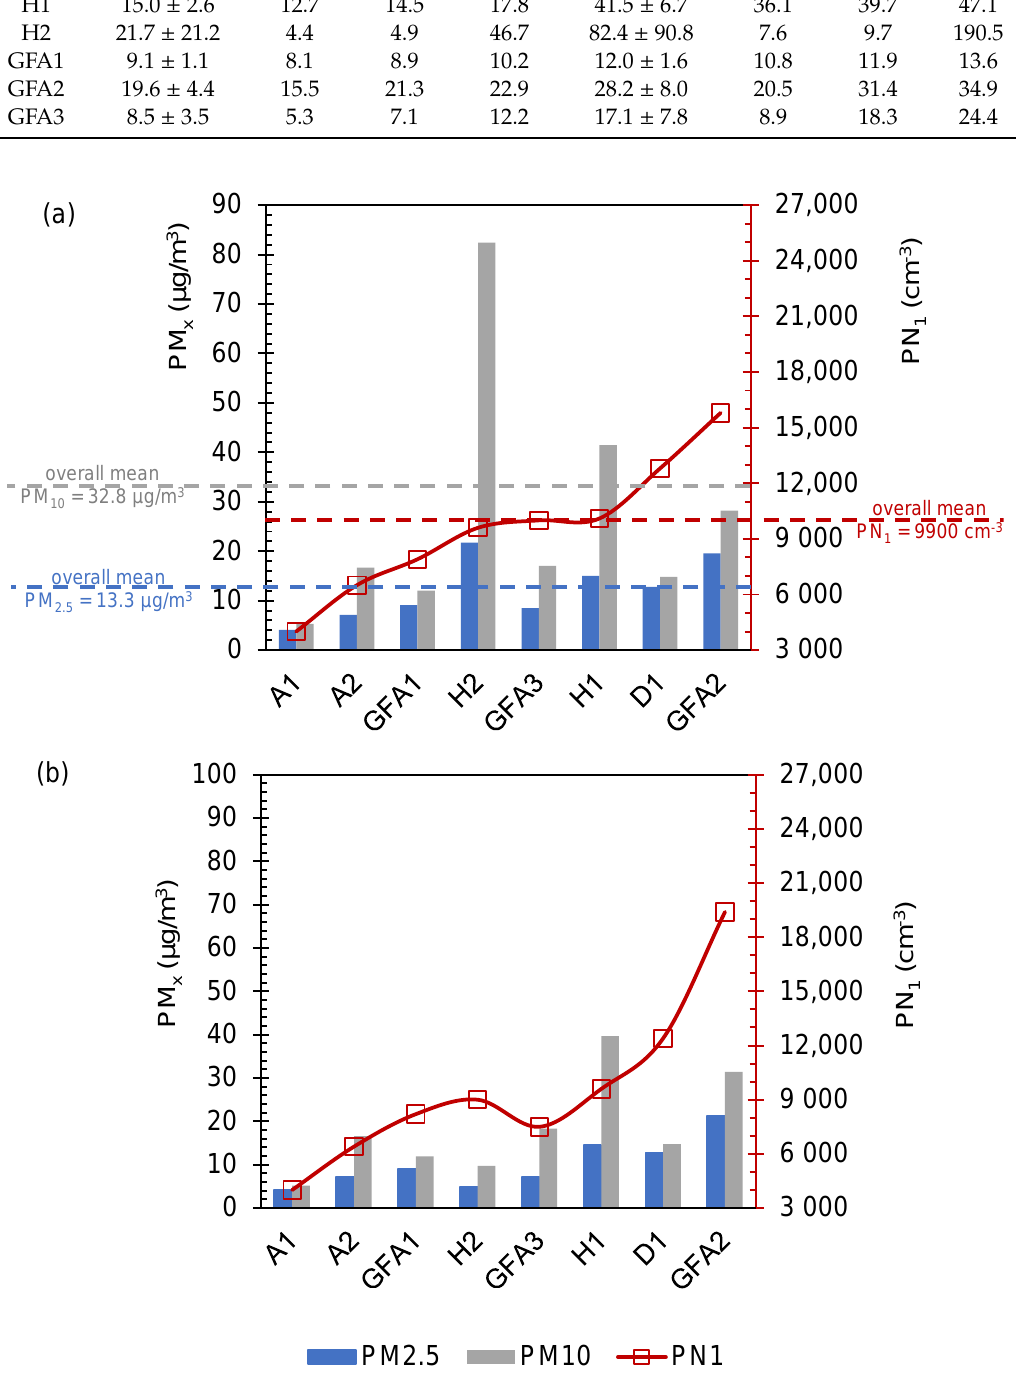
Figure 1. Indoor particle number and mass concentrations in Jordanian homes during background periods: ( a ) mean and ( b ) median.